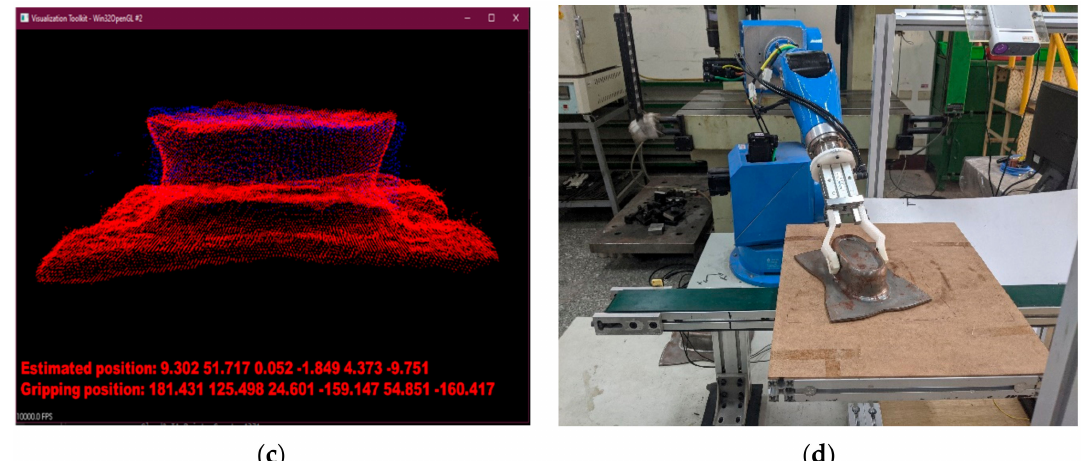
Figure 18. Dynamic single object on the conveyor ( a ) in a random position, ( b ) automatically identifying the RGB point cloud scene of the object, ( c ) estimating the object 6-DoF poses, and ( d ) the robot grasping the object in the dynamic experiment.